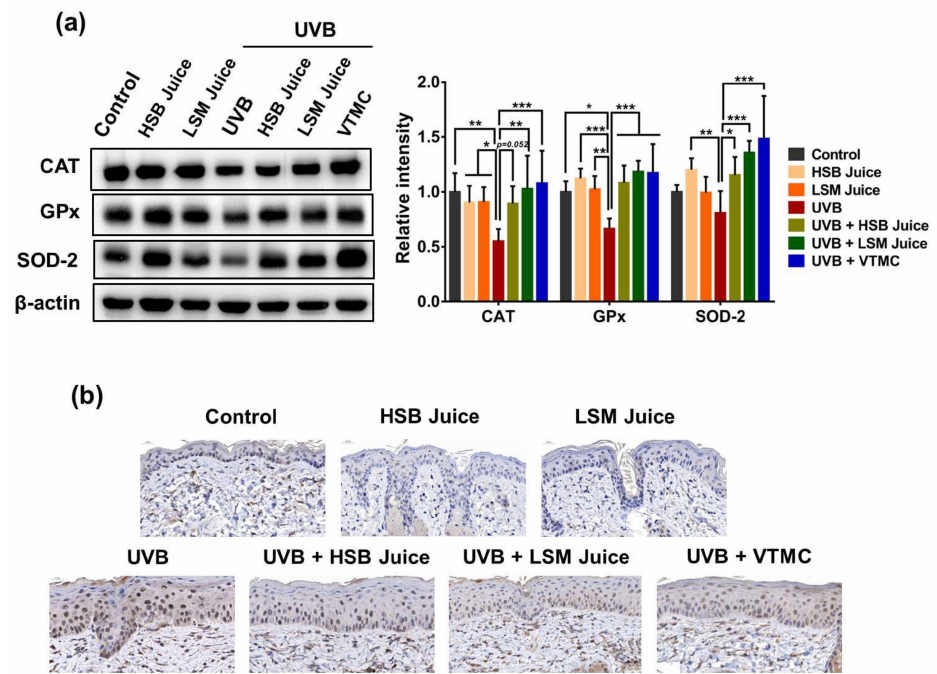
Figure 4. Antioxidant effects of HSB and LSM sweet pepper juices in UVB-irradiated SKH-1 hairless mice. ( a ) Protein expression of CAT, GPx, and SOD-2 in skin tissues; ( b ) Immunostaining for 8-OHdG in skin tissues. Data are expressed as the mean ± SD. * p < 0.05, ** p < 0.01, and *** p < 0.001 values are considered as statistically significant differences. HSB, high-speed blender; LSM, low-speed juicer; VTMC, vitamin